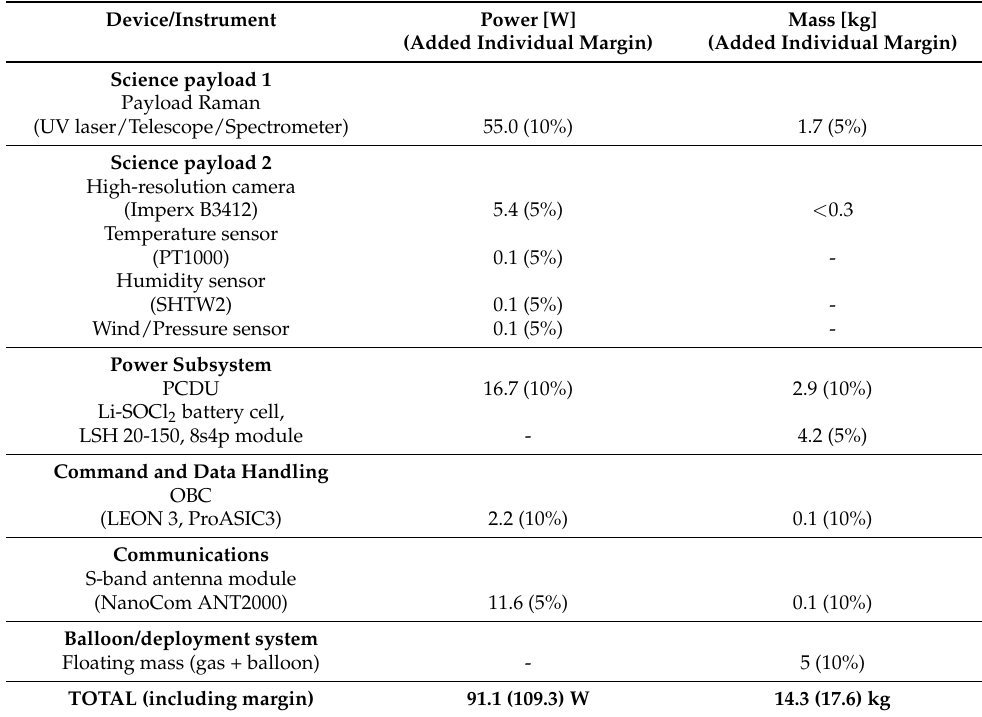
Table 2. System power and mass